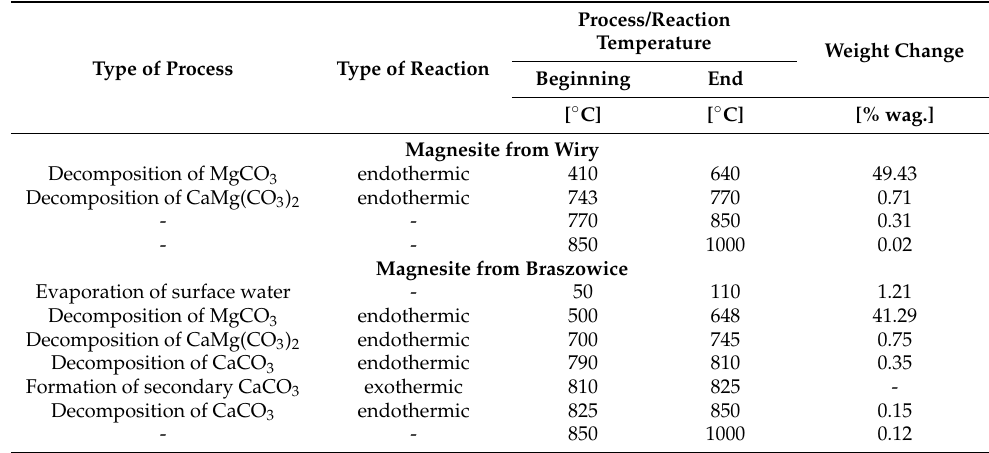
Table 6. Thermal effects occurring during heating of magnesites from Wiry and Braszowice in the temperature range up to 1000 ◦